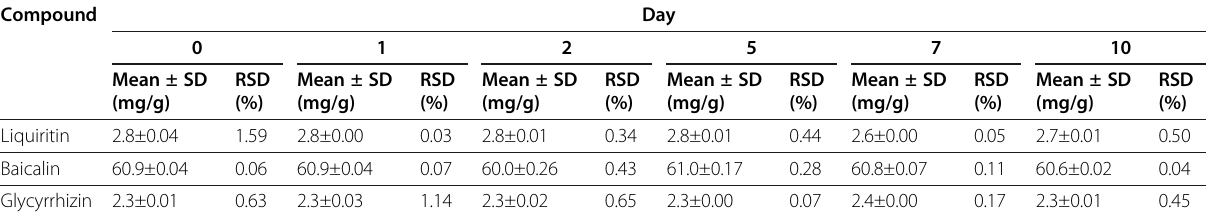
Table 5 Stability of three components for 10 days in the SST (n=3)